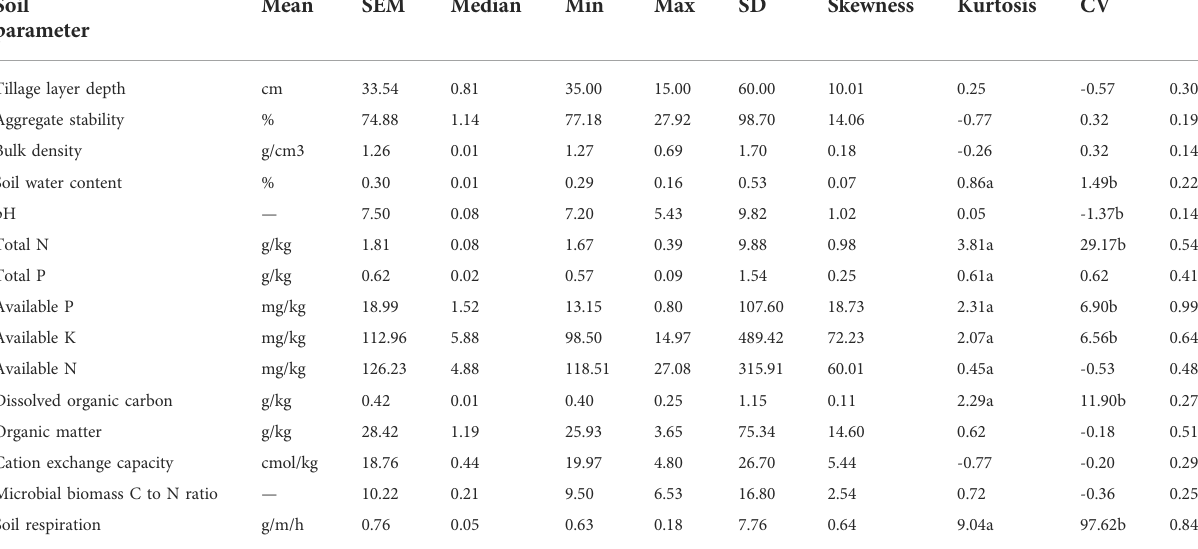
TABLE 2 Summary of the descriptive soil parameters (n =